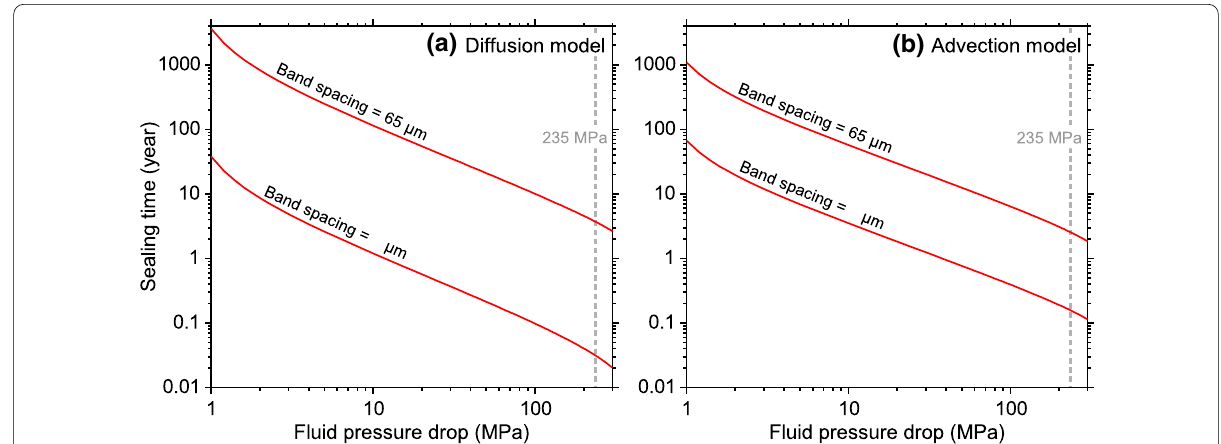
Fig. 5 Relationship between fluid pressure drop and time for crack-sealing by local diffusion ( a ) and by fluid advection ( b ). Vertical dotted lines represent the fluid pressure drop from lithostatic to hydrostatic values at a depth of 15